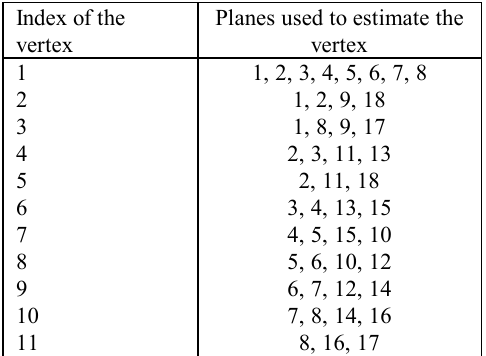
Table 11. Map of the index of each vertex and the planes used to estimate it for Scenario 3.